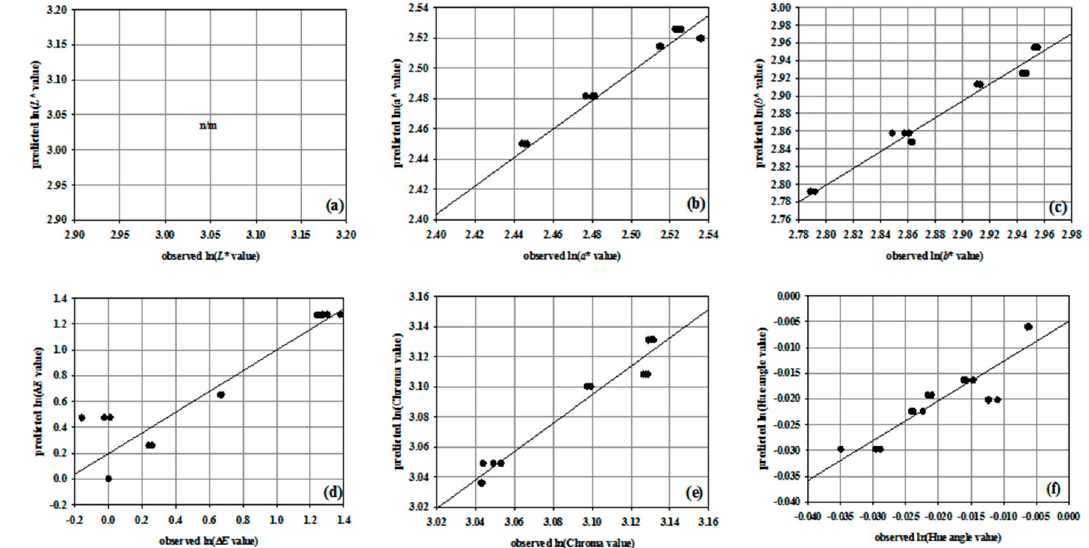
Figure 7. Linear regression models for description of colour components change during storage of V1KMK estimated using the Eureqa Formulize: ( a ) L *, ( b ) a *, ( c ) b *, ( d ) Δ E , ( e ) Chroma, ( f ) Hue angle ( R 2 = 0.714, 0.856, 0.400, 0.724, 0.509, 0.561).